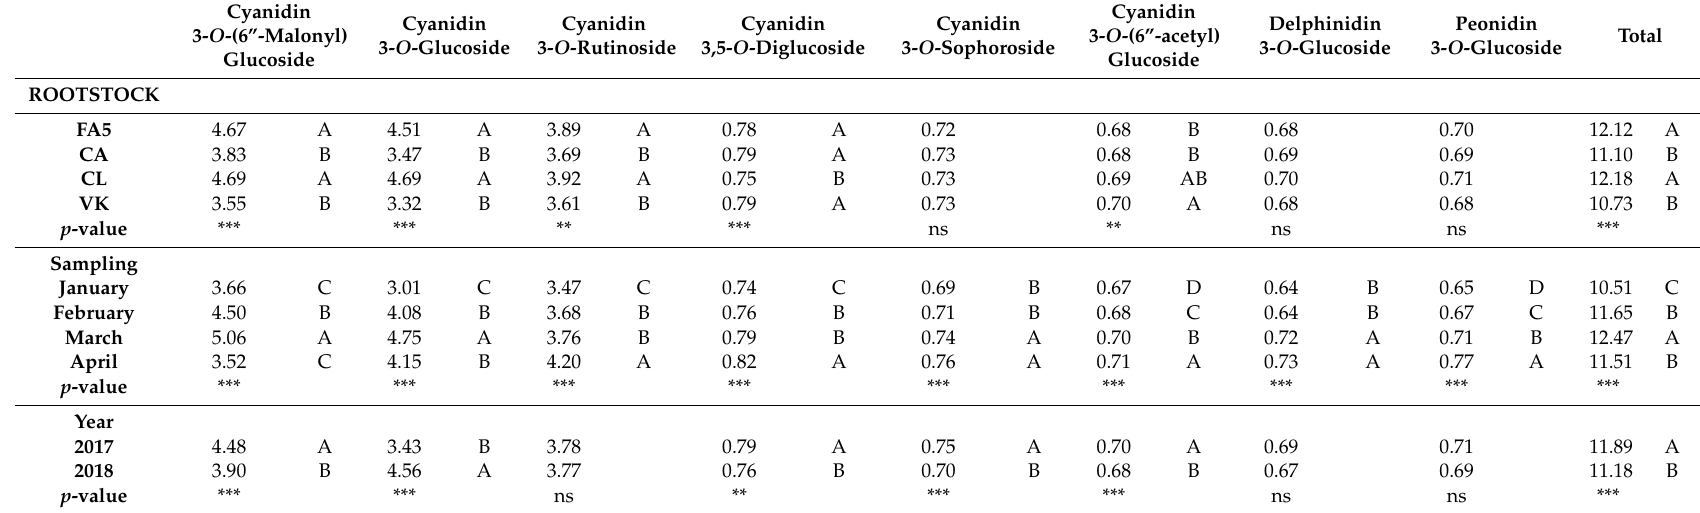
Table 3. E ff ect of rootstock, sampling date, and year on anthocyanin concentration in ‘Sanguinelli’ cultivars. Anthocyanins are expressed in mg / 100 g FW. Cyanidin Cyanidin Cyanidin Cyanidin Cyanidin Cyanidin Delphinidin Peonidin 3- O -(6”-Malonyl) 3- O -(6”-acetyl) Total 3- O -Glucoside 3- O -Rutinoside 3,5- O -Diglucoside 3- O -Sophoroside 3- O -Glucoside 3- O -Glucoside Glucoside Glucoside ROOTSTOCK